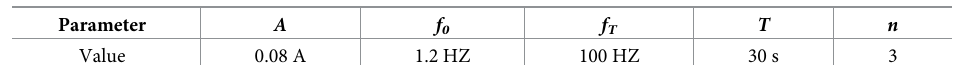
Table 3. The parameters of the sinusoidal frequency sweep